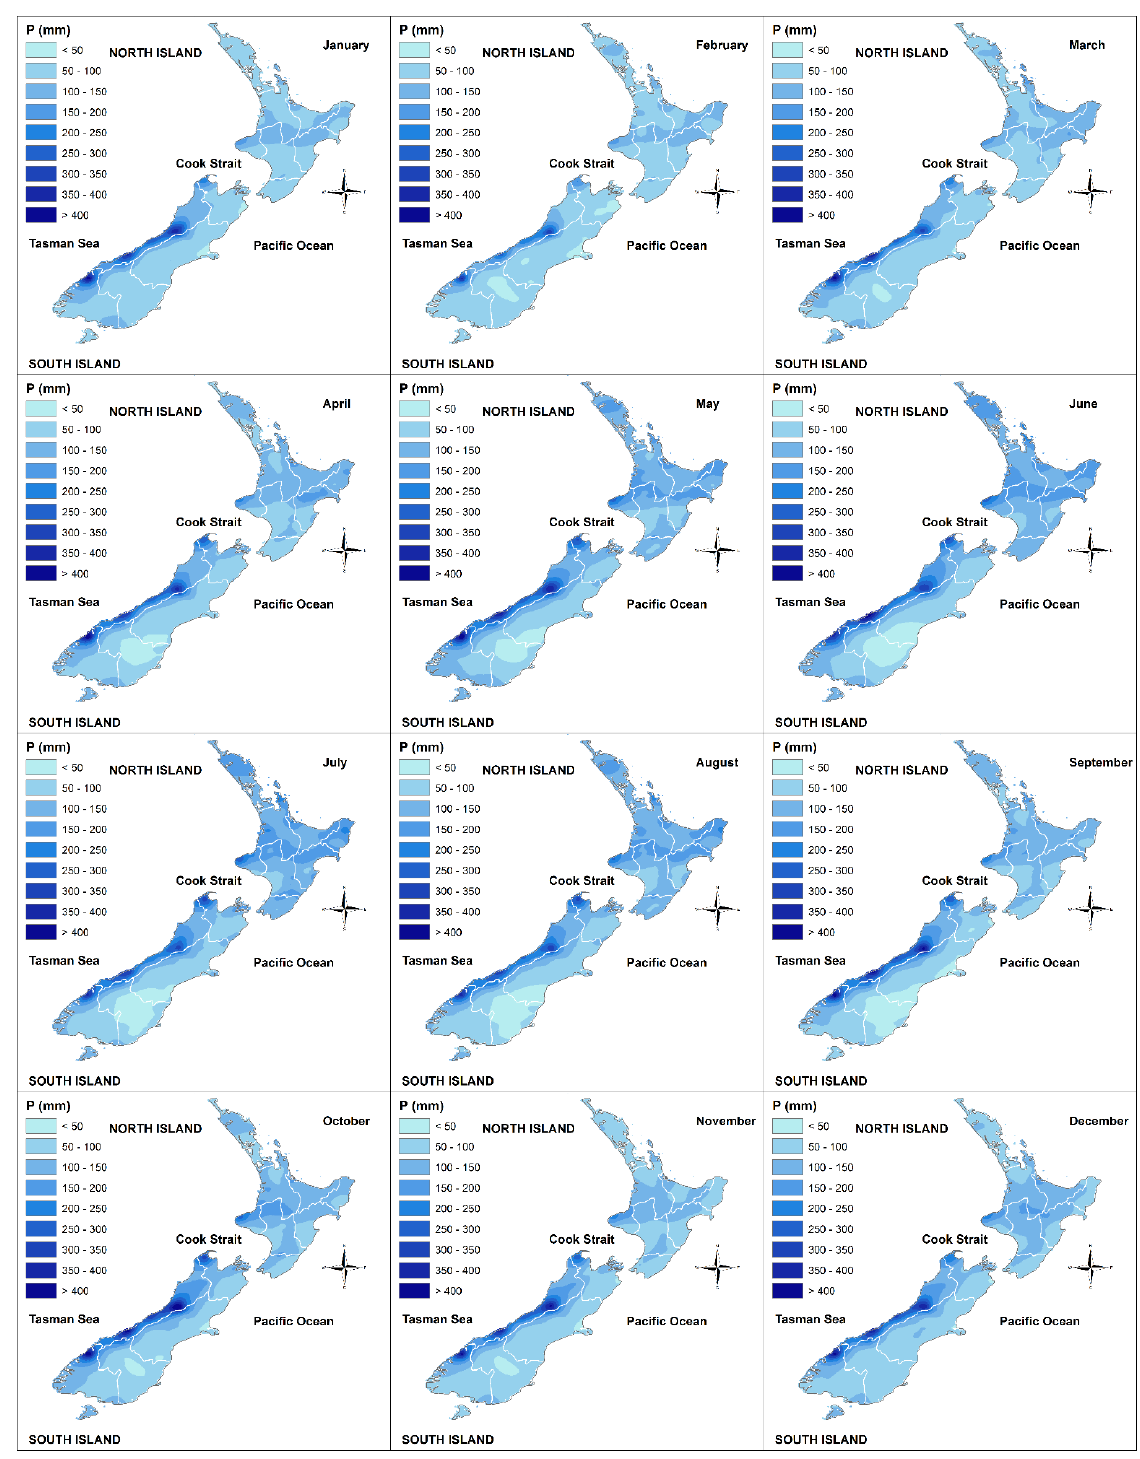
Figure 4. Mean monthly precipitation interpolated using ordinary kriging (OK) method.